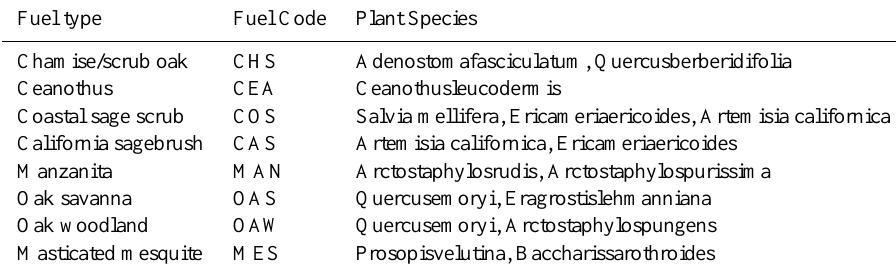
Table 1. Fuel type species composition and abbreviations.